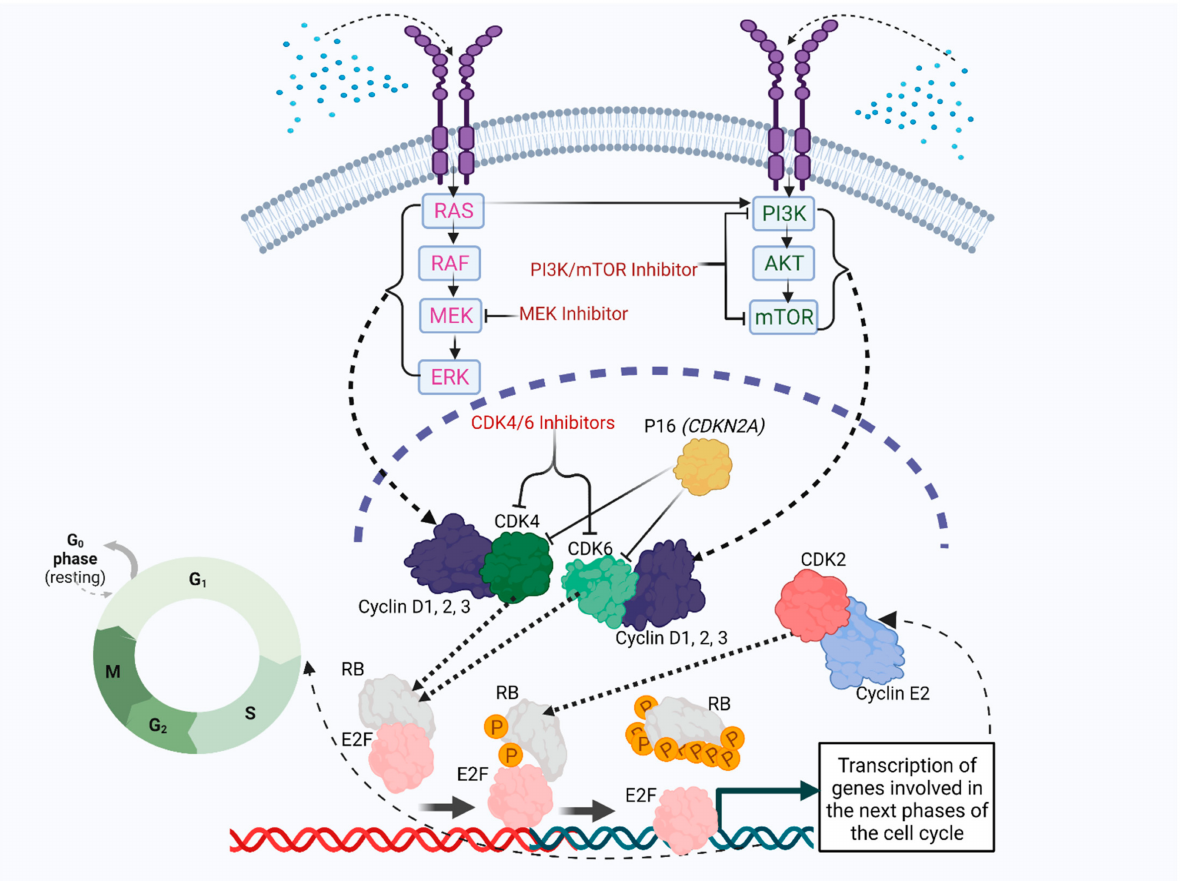
Figure 1. Targeting dysregulation of Cyclin D–CDK4/6 axis by CDK4/6 inhibition. Cyclin D-CDK4/6-mediated RB phosphorylation occurs upon activation of Cyclin D-CDK4/6 com- plex in response to extracellular signals such as stimulatory mitogens, leading to ensuing cell cycle progression. Initially, upon Cyclin D-CDK4/6-mediated RB phosphorylation, RB affinity to E2F is reduced, promoting transcription of genes such as Cyclin E2. Subsequently, the Cyclin E2-CDK2 complex hyperphosphorylates RB, which induces full dissociation of the RB-E2F complex and tran- scription of genes encoding proteins playing critical roles in the next phases of the cell cycle. The p16 INK4A (p16) tumor suppressor encoded by CDKN2A directly binds to CDK4/6 and inhibits the formation of the Cyclin D-CDK4/6 complex and prevents Cyclin D-CDK4/6-mediated RB phospho- rylation. A dysregulated Cyclin D–CDK4/6 axis, which leads to uncontrolled cell proliferation, can be inhibited by CDK4/6 inhibitors. Chronic inhibition of CDK4/6 can trigger the upregulation of PI3K and MAPK pathways to compensate for inhibitory effects of CDK4/6 inhibitors on cell cycle progression by activation of D type cyclins. Dual inhibition of CDK4/6 and PI3K/mTOR or MEK may be an efficient combination treatment to prevent the compensatory effect of the PI3K or MAPK pathways on the development of CDK4/6 inhibitor